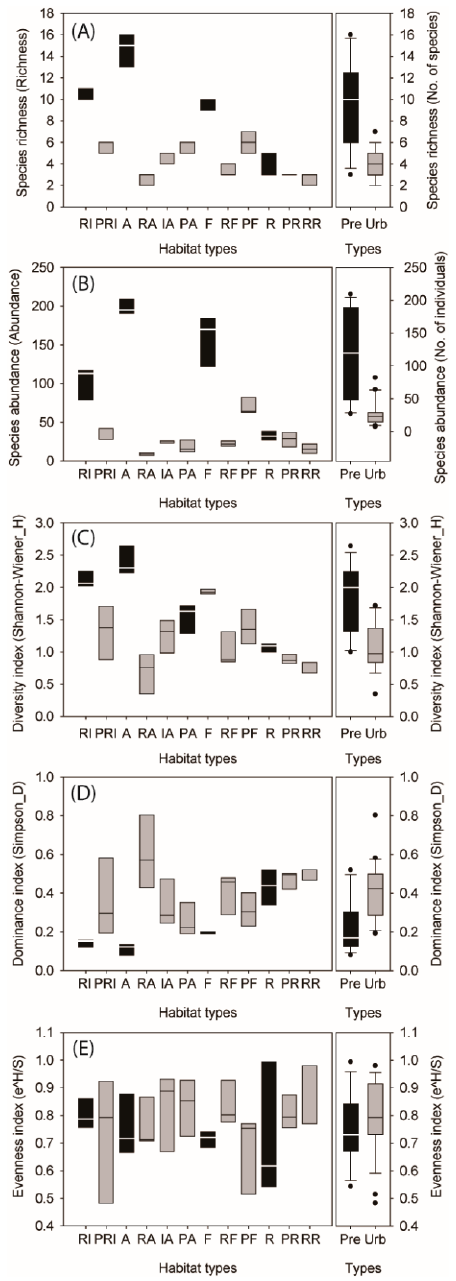
Figure 2. Average species richness ( A ), abundance ( B ), diversity index ( C ), dominance index ( D ), and evenness index ( E ) of each land-use types including former (black plots) and current (gray plot) land-use types; RI: Riparian area, R: Residential area, RA: Residential area from agricultural land, RF: Residential area from forest, PF: Park from forest, PR: Park from residential area, PA: Park from agricultural land, PRI: Park from riparian area, IA: Industrial land from agricultural land, RR: Redevelopment area from residential area, For: Former habitats, Cur: Current habitats.